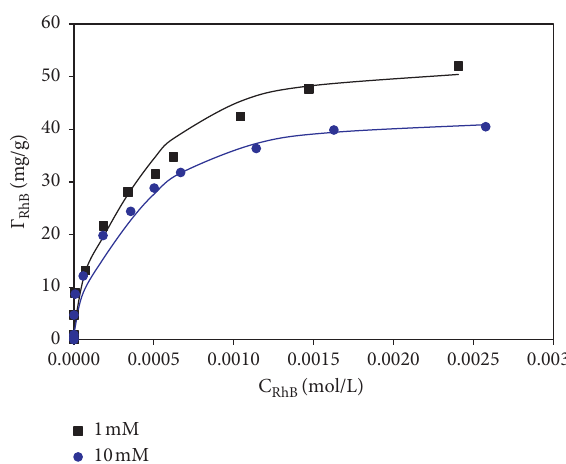
Figure 5: Adsorption isotherms of RhB onto SDS-modified α -Al 2 O 3 nanoparticles ( M 1) at two NaCl concentrations. The points are experimental data while solid lines are fitted by the two- step adsorption model.